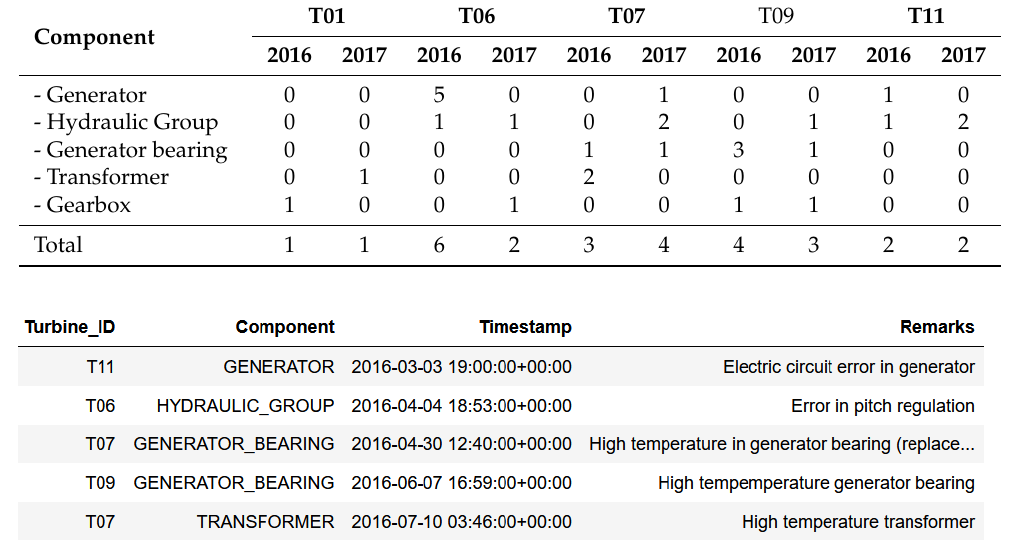
Table 1. Failure summary.